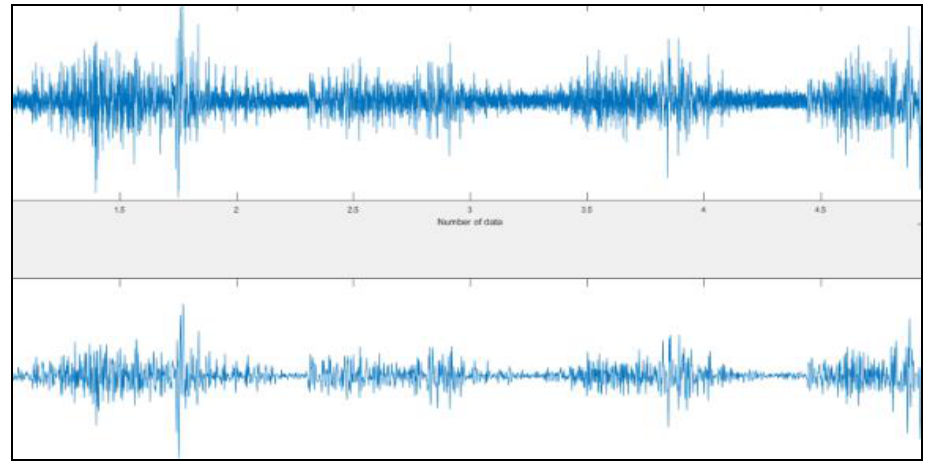
Figure 4. ( Top ) raw data, and ( bottom ) filtered data. The filtered EMG signal reduced noise by about 40% compared to the raw signal. raw